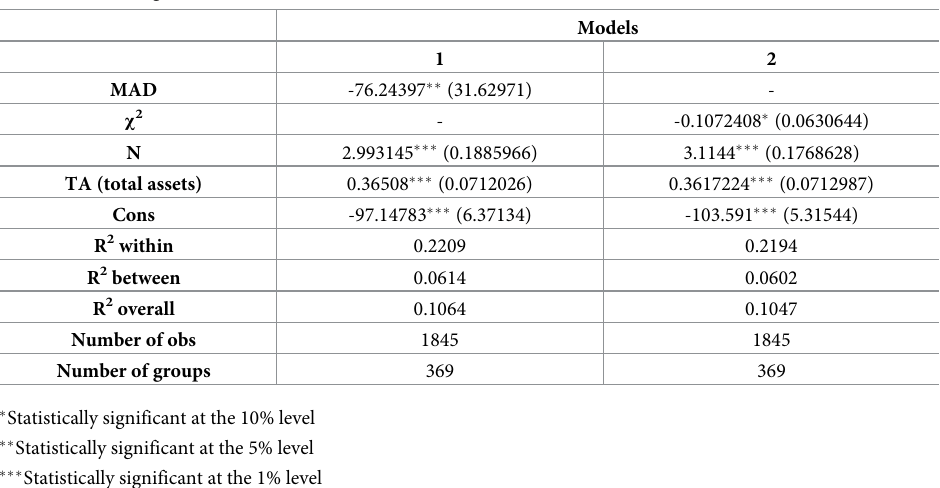
Table 3. Pooled regression results (fixed